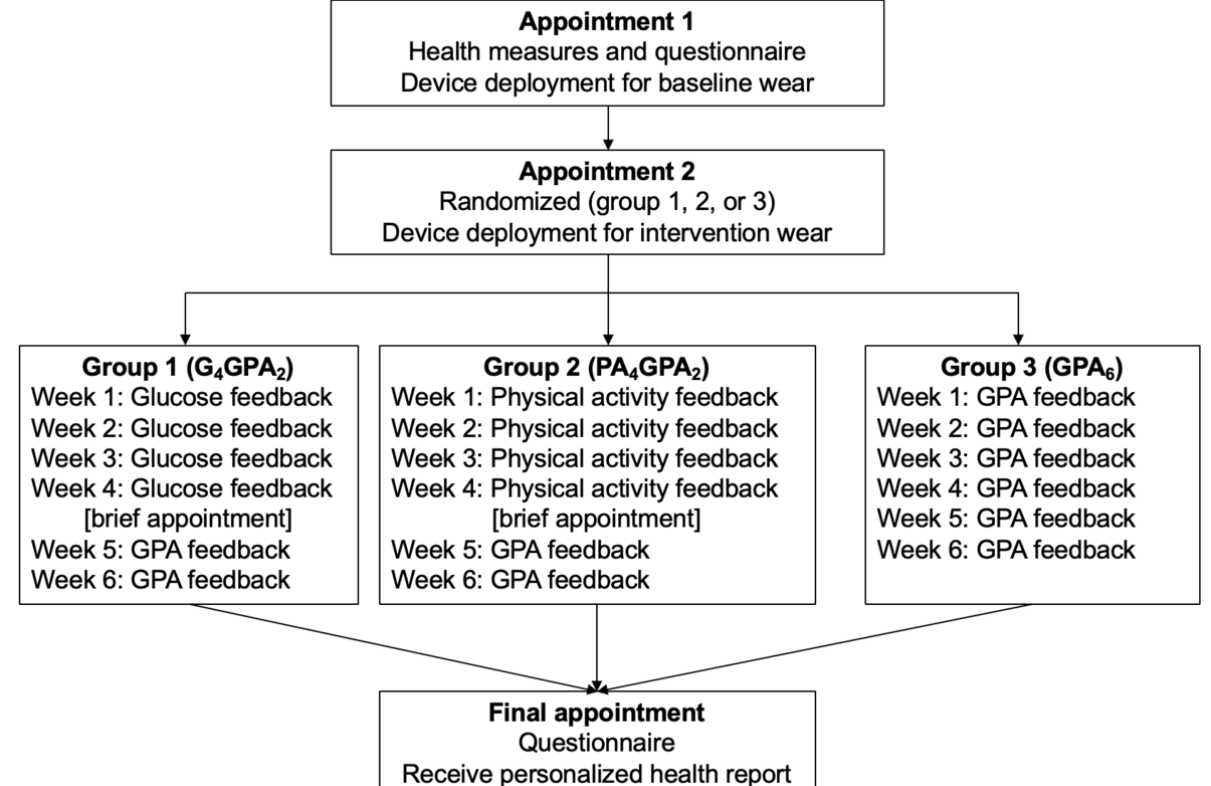
Figure 1. An outline of the study flow from the first appointment through to the end of participation. GPA: glucose and physical